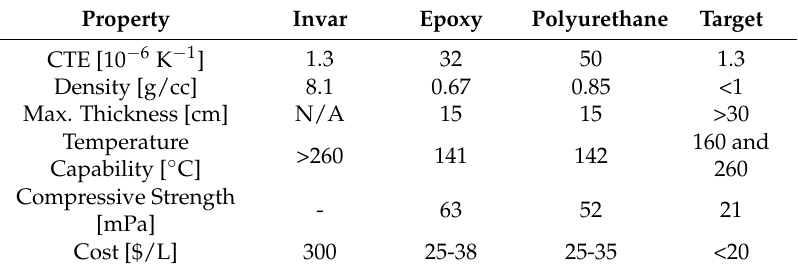
Table 1. Properties of existing tooling materials and target materials